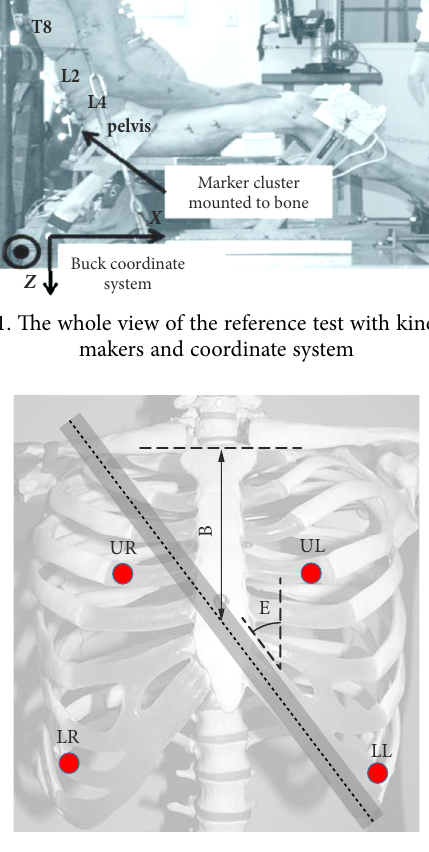
Figure 2. Diagram between measuring points